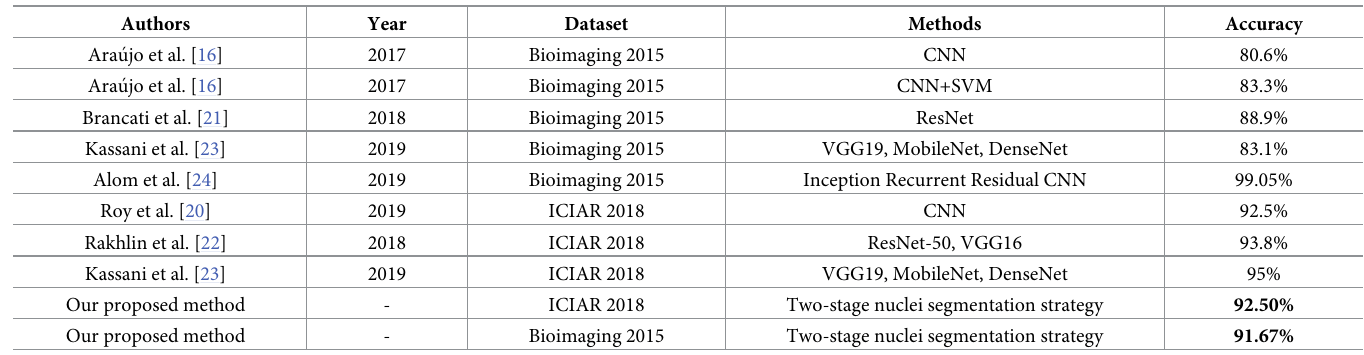
Table 11. Comparison of accuracy with previous